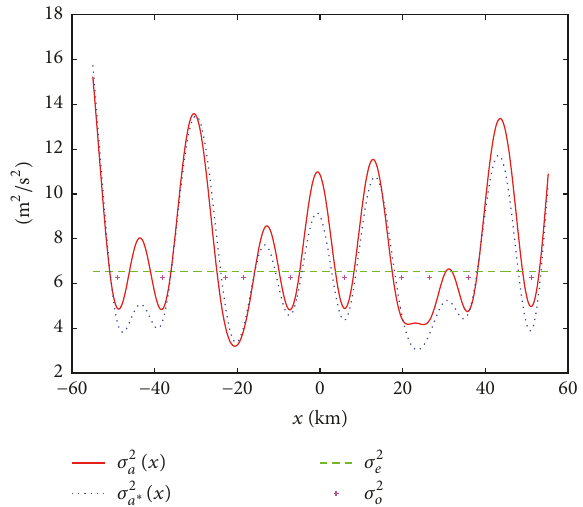
Figure 8: As in Figure 5 but without periodic extension.